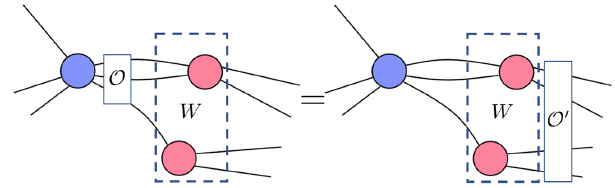
FIG. 15. A nonproduct operator O can be pushed to the right through the adjacent operators (pink) by treating them collec- tively as a single tensor W with suitable unitary